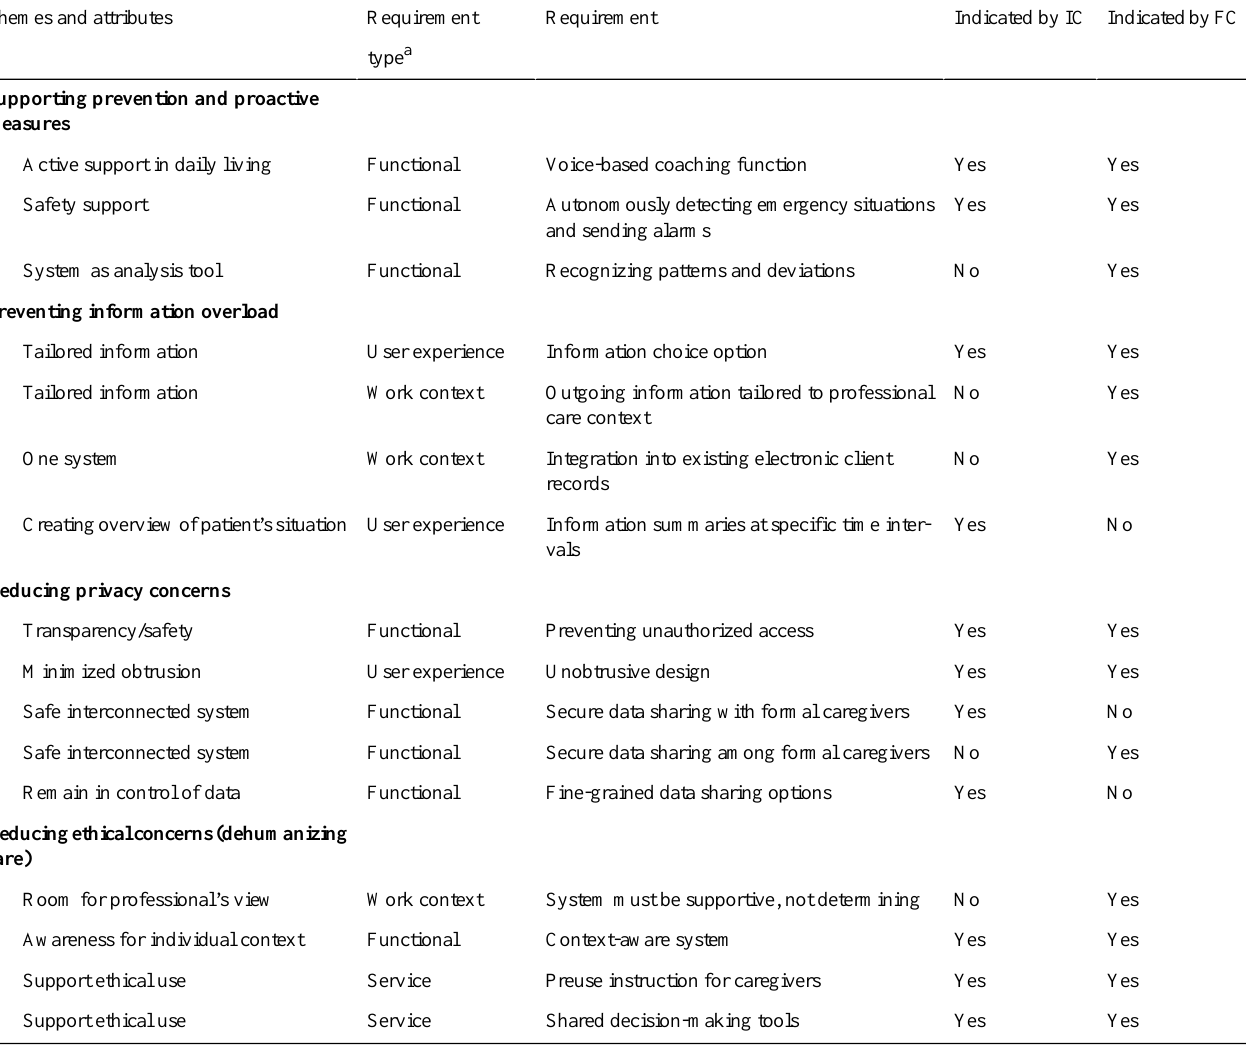
Table 4. Requirements toward unobtrusive in-home monitoring based on informal caregiver (IC) and formal caregiver (FC)